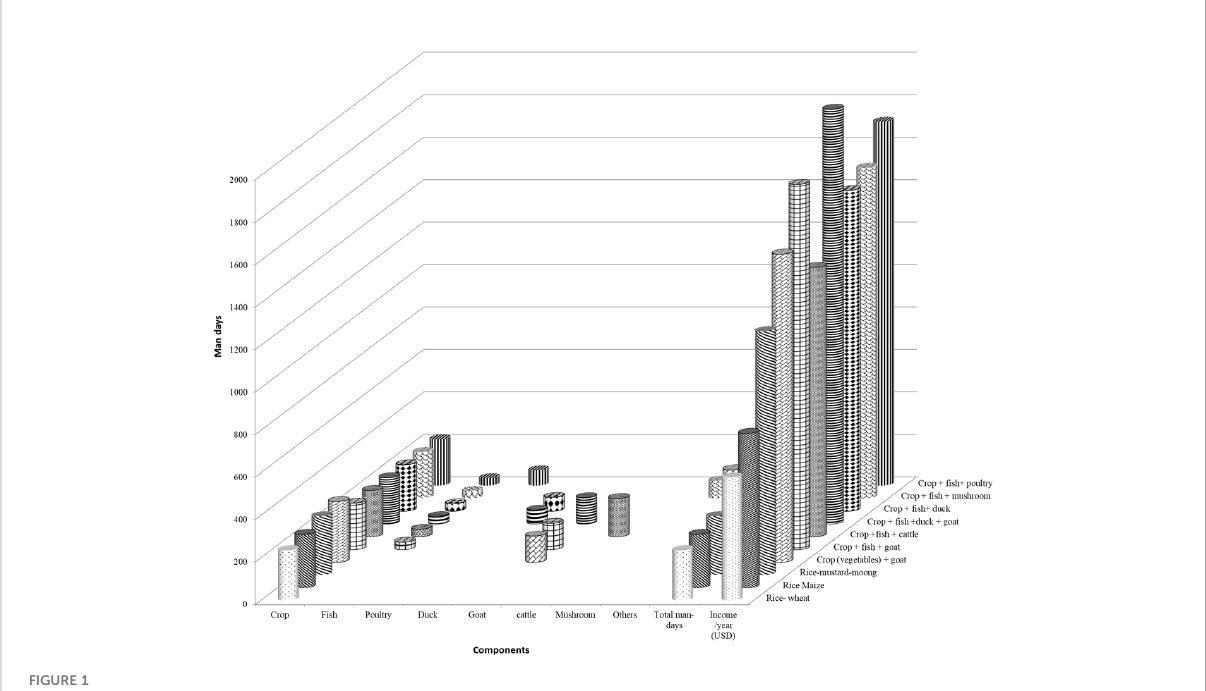
FIGURE 1 Yearly man- days requirement by different IFS components.